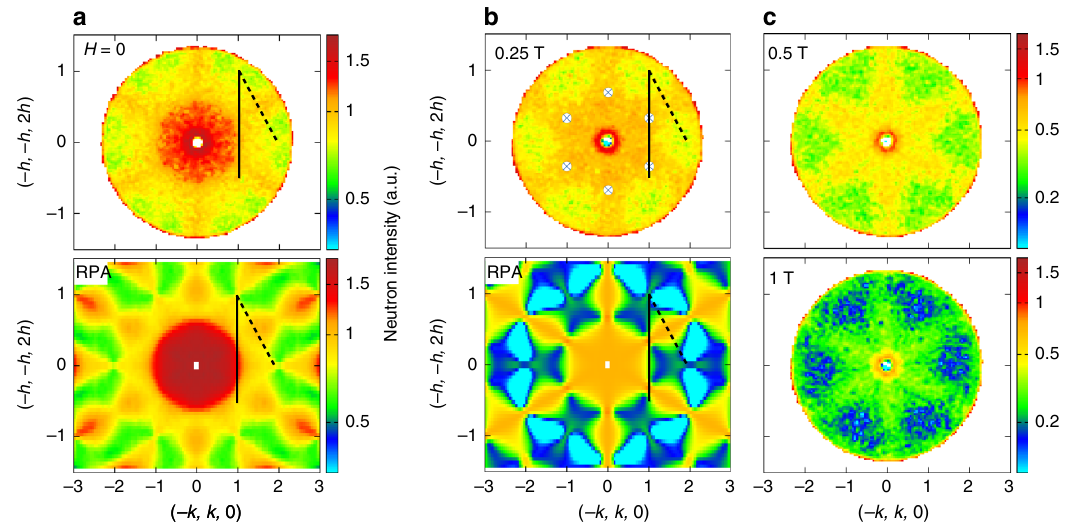
Fig. 3 Dynamic kagome ice state seen in inelastic neutron scattering for H || [111]. Inelastic intensity averaged around E = (50 ± 5) μ eV (corresponding to the energy shown by the red arrow in Fig. 4). a Zero- fi eld measurements at 60 mK and Random Field Approximation (RPA) calculations for the pseudo- spin 1/2 model described in the text with J x = − 0.36 K, J y = 0.066 K, J z = 0.86 K, and J xz = 0.44 K at T = 0. b Measurements in 0.25 T at 60 mK and calculations with the same parameters. The crossed circles mark the position of the expected pinch points, which appear blurred in the measurements. c Measurements at 0.5 and 1 T. The black full and dashed lines indicate the directions of the slices along ( − 1 − h , 1 − h , 2 h ) and ( − 2, h , 2 − h ) shown in Fig. 4